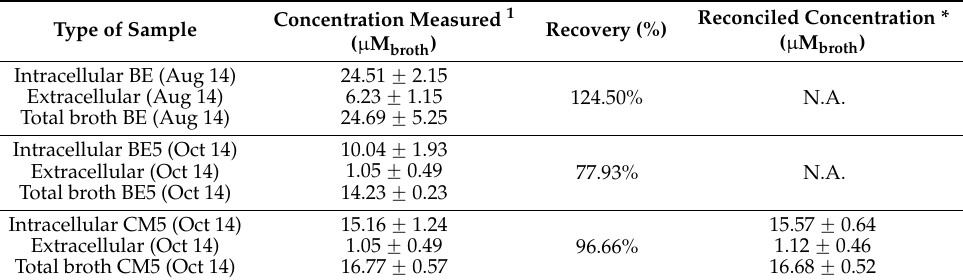
Table 2. Results of total broth ammonium mass balance. Reconciled concentrations provide the best estimates of the measurements obtained by least square minimization of the differences between the measurements and estimated amounts, weighted with respect to their measurement errors.